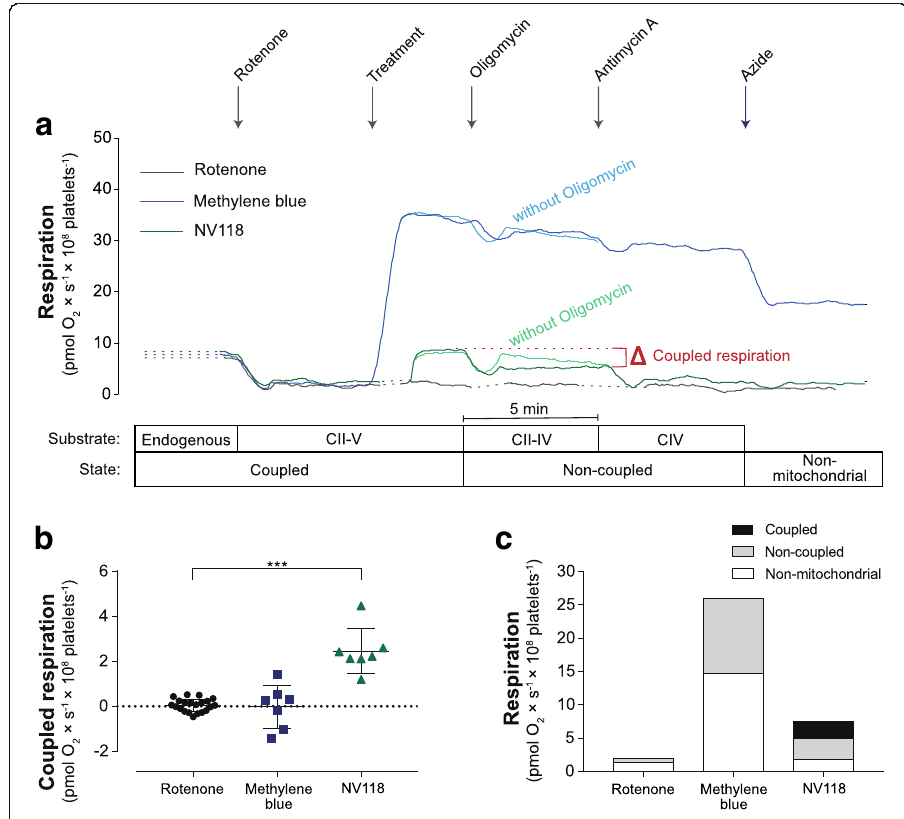
Fig. 2 Effect of methylene blue and NV118 on coupled respiration in rotenone-intoxicated human platelets. a Representative traces of mitochondrial respiration in human platelets with complex I inhibition induced by rotenone (2 μ M). Mitochondrial respiration due to coupled phosphorylation of rotenone-intoxicated platelets treated with vehicle (rotenone, dark gray trace), methylene blue (20 μ M, dark blue trace) or the cell-permeable succinate prodrug NV118 (250 μ M, dark green trace), here referred to as coupled respiration, was evaluated by subsequent addition of the ATP-synthase inhibitor oligomycin (1 μ g/ml) to block the phosphorylation pathway, and calculated as the difference in respiration before and after the inhibition of the ATP-synthase. The protocol was continued by adding the complex III inhibitor antimycin A (1 μ g/ml) followed by the complex IV inhibitor sodium azide (10 mM). Control experiments were performed without the addition of oligomycin to account for background drift of oxygen consumption in the presence of the bypass agents (light blue trace, light green trace). b Quantification of coupled respiration of rotenone-intoxicated platelets treated with vehicle (rotenone, black circle), methylene blue (20 μ M, dark blue square), or the cell-permeable succinate prodrug NV118 (250 μ M, dark green triangle) was calculated as the difference in respiration before and after inhibition of the ATP-synthase. c The coupled respiration, non-coupled respiration, and non-mitochondrial respiration was evaluated in rotenone-intoxicated platelets treated with vehicle, methylene blue, or NV118. Non-mitochondrial respiration was defined as respiration remaining after addition of sodium azide, which all other respiratory values were corrected for. Data are expressed as individual scatter plot and mean ± SD ( b ) or mean ( c ). Rotenone: n = 21, NV118 and methylene blue: n = 7. One-way ANOVA with Dunnet post hoc test was used for comparison of the drug ’ s effect on coupled respiration. *** p < 0.001. CII – V: complex II to V, CII – IV: complex II to IV, CIV: complex